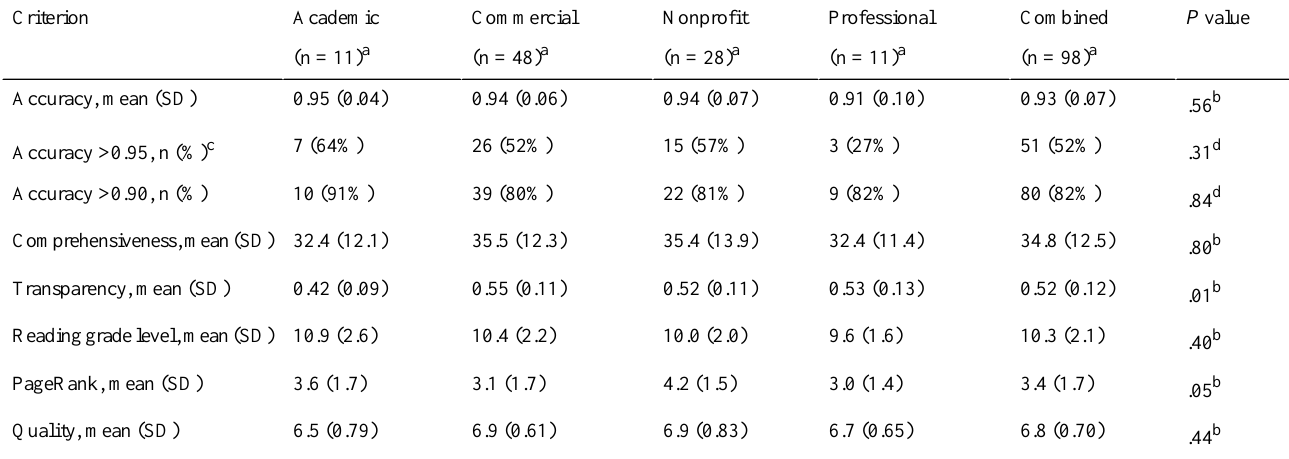
Table 1. Website scores for accuracy, comprehensiveness, transparency, reading grade, PageRank, and quality by website